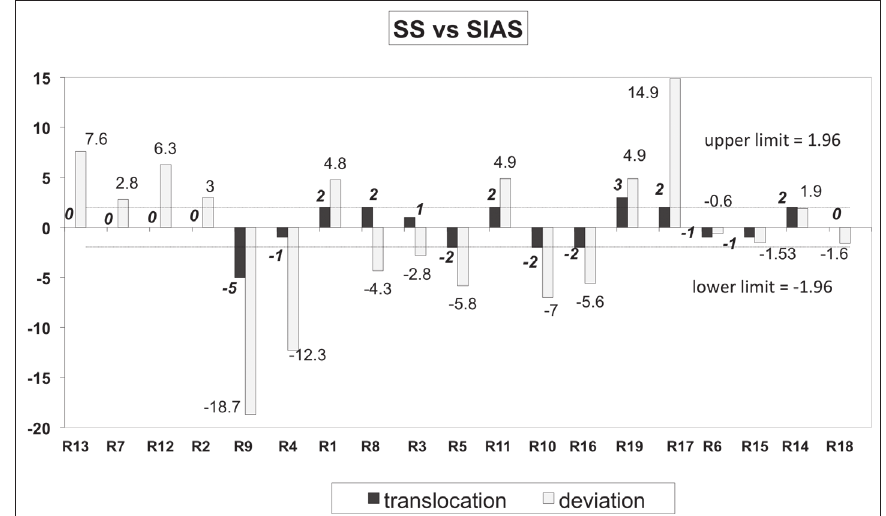
Figure 4 - Services Subsector (SS) vs SIAS Dual Comparison.